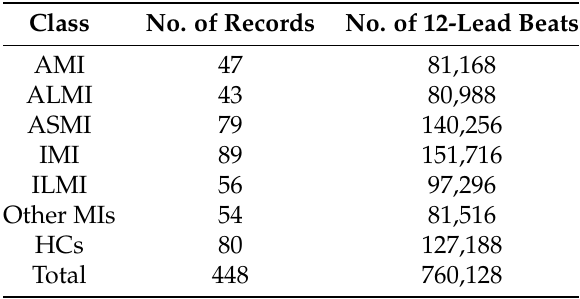
Table 1. Summary of Physikalisch-Technische Bundesanstalt (PTB) dataset in this